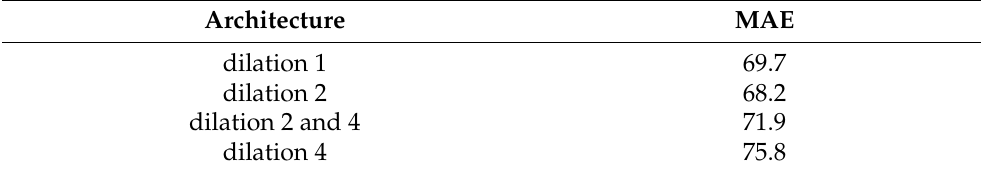
Figure 15. Learning and convergence rate, and loss of CSRNet with a dilation rate of 1 in the backbone (note that the plots in Figure 13 are based on a dilation rate of 2). Here, all 16.2 million parameters are adjusted at once using the Adam optimizer. ( a ) The pixel-wise MAE is shown over 1000 epochs for the training set (blue) and the validation set (red). ( b ) The training and the validation Euclidean losses are shown over 1000 epochs. Table 2. Estimation errors on the ShanghaiTech Part A dataset with different dilation strategies in the backbone. The numbers taken from [9].